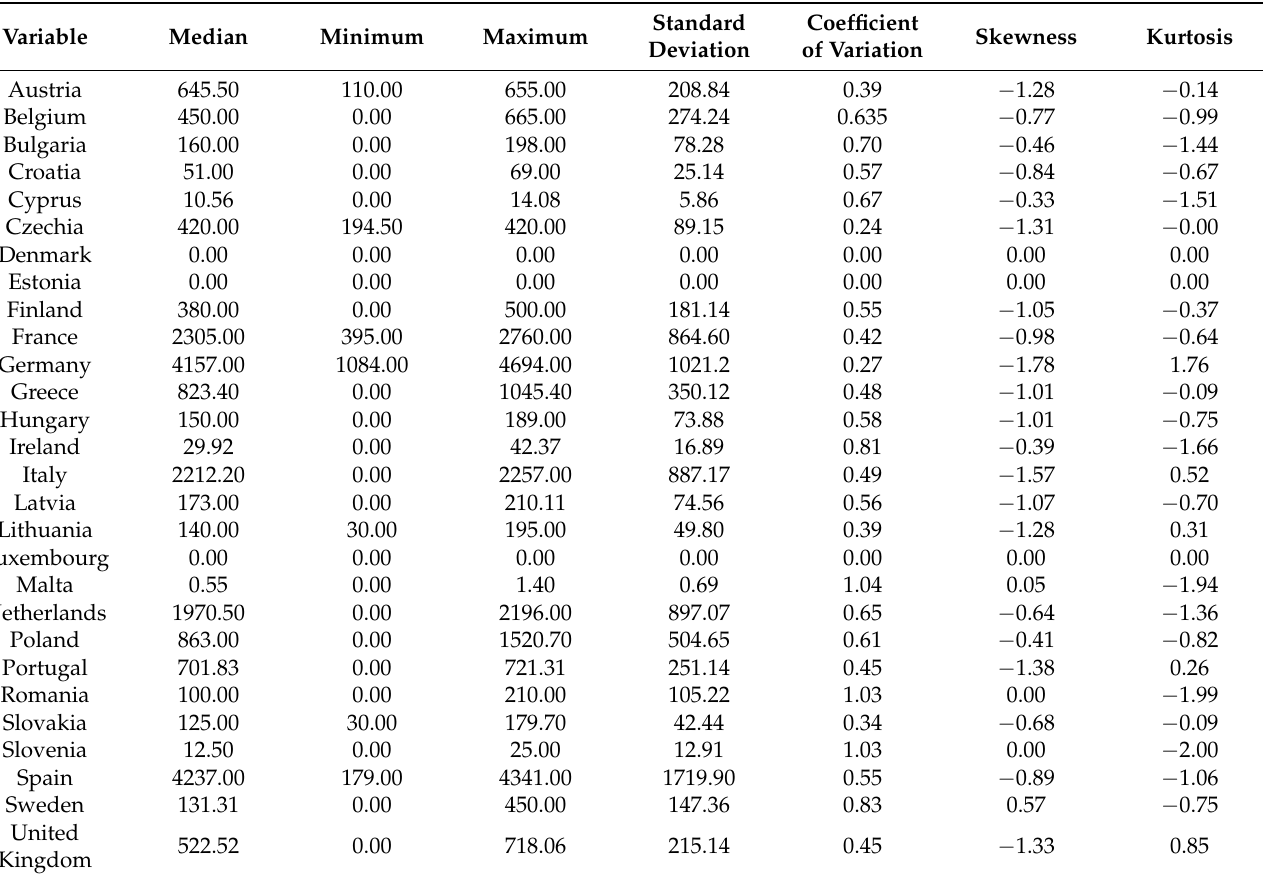
Table 2. Descriptive statistics for biodiesel production in the European Union (EU) from 2004 to 2019 (thousand tons).